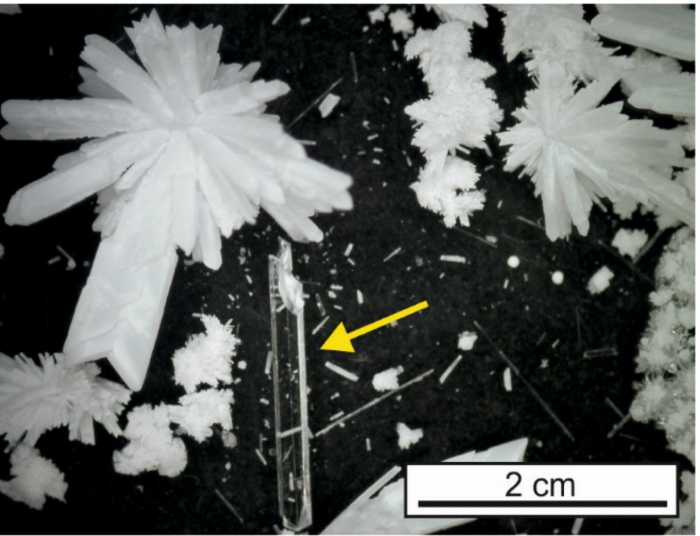
Figure 5. A clear untwinned gypsum crystal grown in the supernatant section (arrow) in comparison with crystal aggregates from the